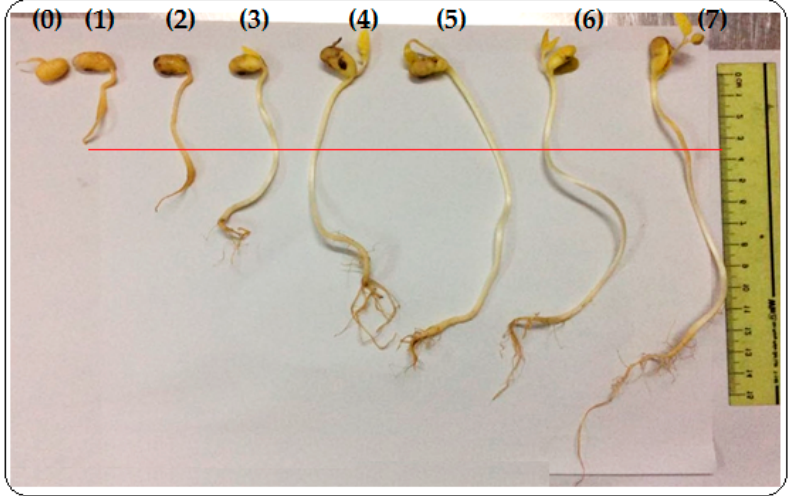
Figure 1. Germination progress of soybean seeds over 7 days.